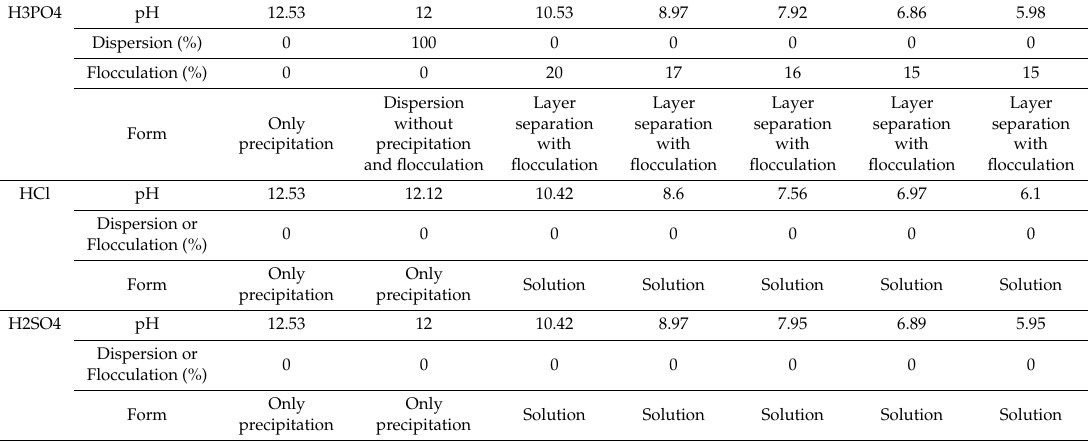
Figure 1. Addition to H 3 PO 4 , HCl to BiSCaO-6 suspension. Various amounts of H 3 PO 4 ( a ) or HCl ( b ) were added to 2000 ppm (0.2 wt%) BiSCaO ‐ 6 water suspensions to adjust the pH to around 6, 7, 8, 9, 10.5, and 12. Table 1. Changes in BiSCaO-6 suspensions by the addition of H 3 PO 4 , HCl , or H 2 SO 4. Table 2. Changes in BiSCaO ‐ 6 water suspensions by the addition of Na 3 PO 4 , Na 2 HPO 4, or NaH 2 PO 4 .